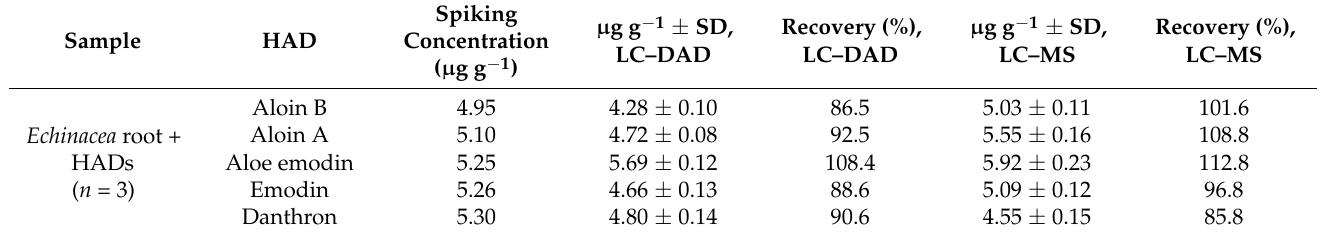
Table 3. Recovery of HAD reference standards added to Echinacea extract and simple syrup in LC–DAD and